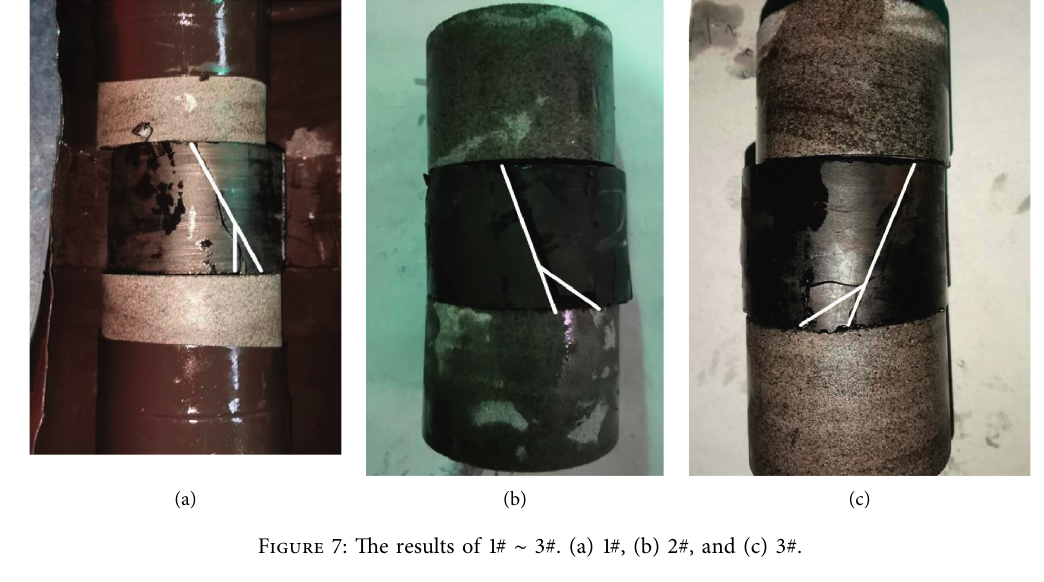
Figure 7: The results of 1# ∼ 3#. (a) 1#, (b) 2#, and (c) 3#.